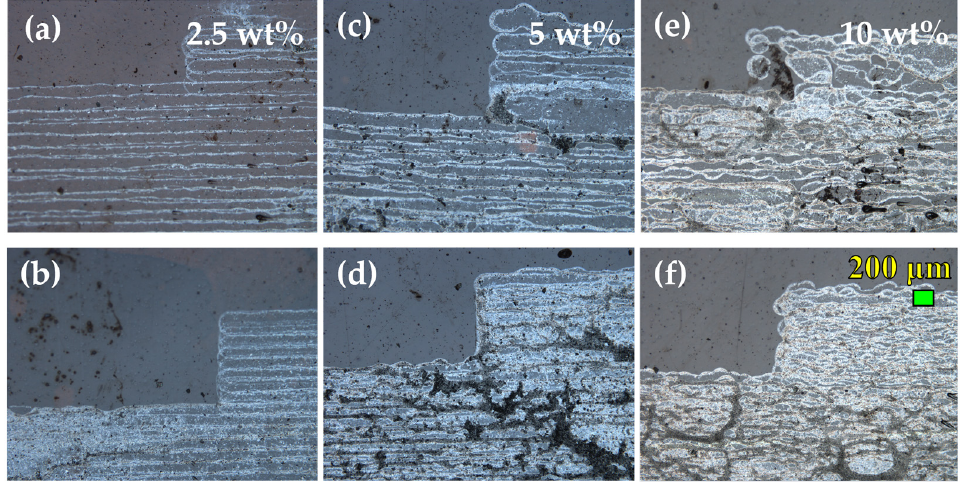
Figure 10. Optical microscope images for different f –rGO concentrations: ( a , c , f ) one-pass; ( b , d , e ) three-pass pads of the devices.